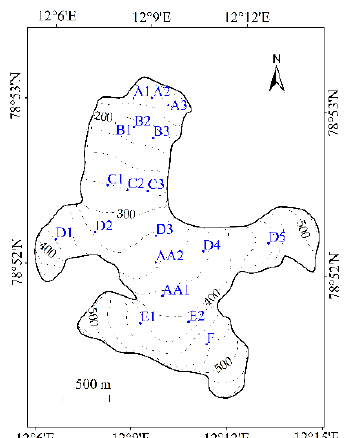
Figure 1. Distribution of 19 stakes on AL. Stakes A1, A2, A3, B1, B2, B3, C1, C2, C3, D1, D2, D3, D4, D5, E1, E2 were built in August 2005. Stake F was built in July 2007. Stakes AA1 and AA2 were built in May 2016.